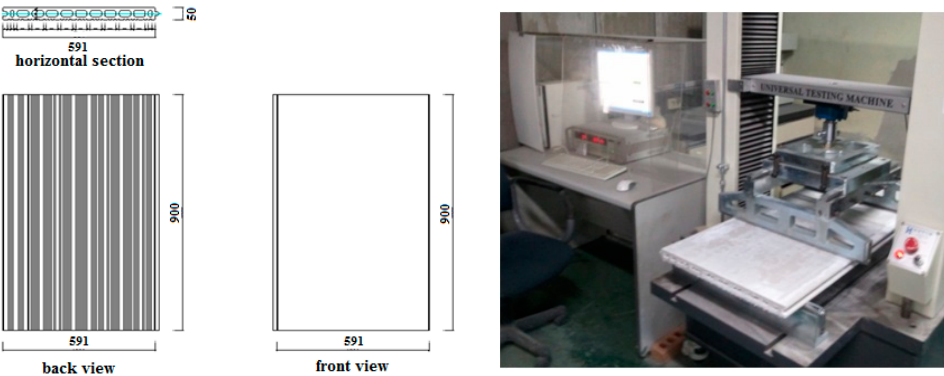
Figure 9. Shapes of panel specimens ( left ) and flexural strength testing set-up ( right ). Appl. Sci. 2017 , 7 , 910